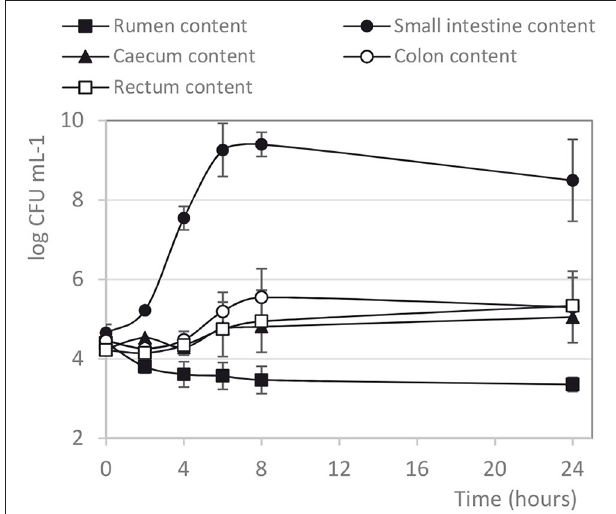
FIGURE 2 | Growth curves of E. coli MC2 Rif R incubated in bovine digestive contents. The E. coli strain MC2 Rif R was incubated in bovine digestive contents under conditions described in the Materials and Methods section. Each time point is the mean of at least three independent experiments. Statistical analyses were performed with two-way ANOVA with the Bonferroni post-hoc test: growth yield in small intestine content was significantly different from the other DC ( p < 0.001); growth yield in colon and rectum contents was significantly different from that in rumen content ( p <